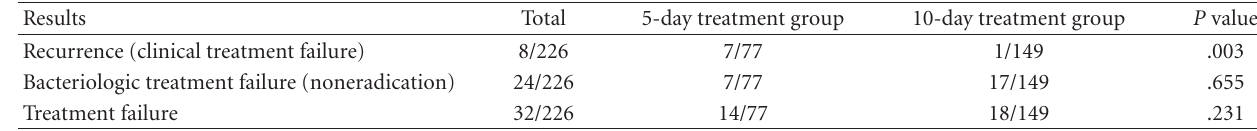
Table 2: Clinical and bacteriological results.